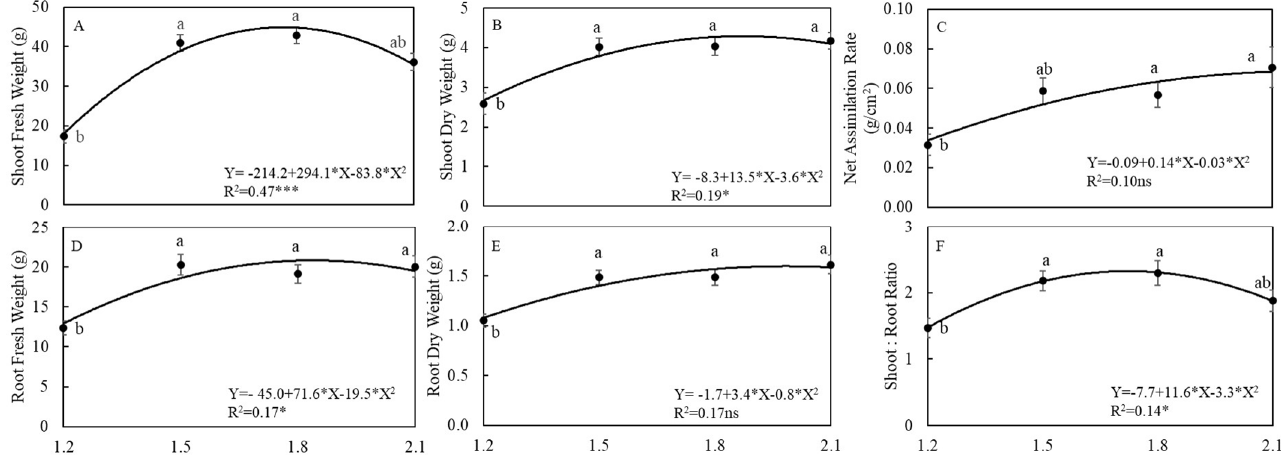
Figure 4. ( A ) Shoot fresh weight, ( B ) shoot dry weight, ( C ) net assimilation rate, ( D ) root fresh weight, ( E ) root dry weight, and ( F ) shoot to root weight ratio of arugula 4 weeks after transplanting into a nutrient-film technique hydroponic system containing nutrient solutions with electrical conductivity (EC) of 1.2, 1.5, 1.8, or 2.1 dS·m − 1 . Data points with different letters are significantly different according to Tukey’s test ( α = 0.05). Error bars represent standard errors ( n = 32). ns, * or *** indicate no significance or significance at P of 0.05 or 0.001, respectively.